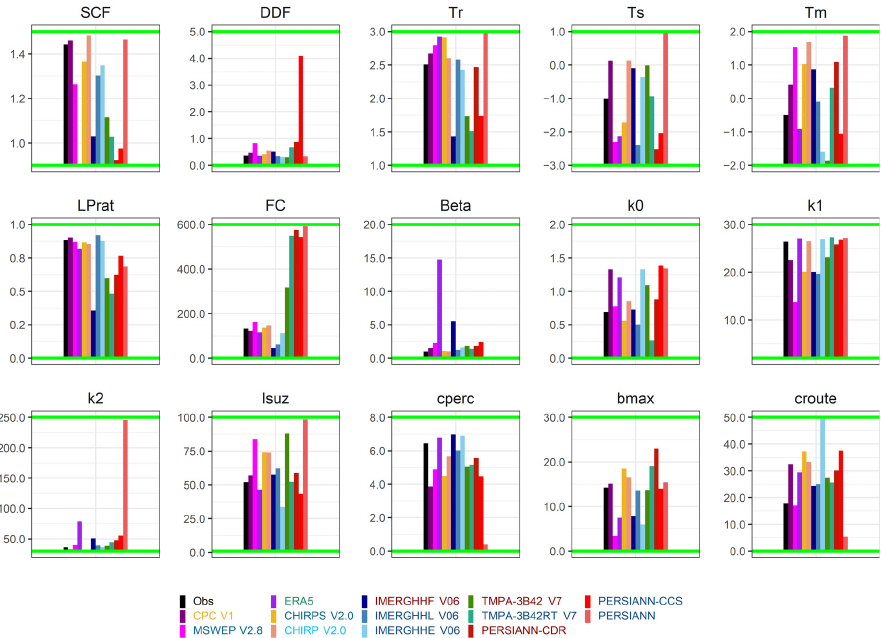
Figure 12. Optimum TUW model parameters for the observed and 13 GPDs. Legend text color presents: observed (black), satellite-based (blue), gauge and satellite (red), reanalysis and satellite (sky blue), reanalysis (green), reanalysis, ground, and satellite (steel blue), and ground (yellow).